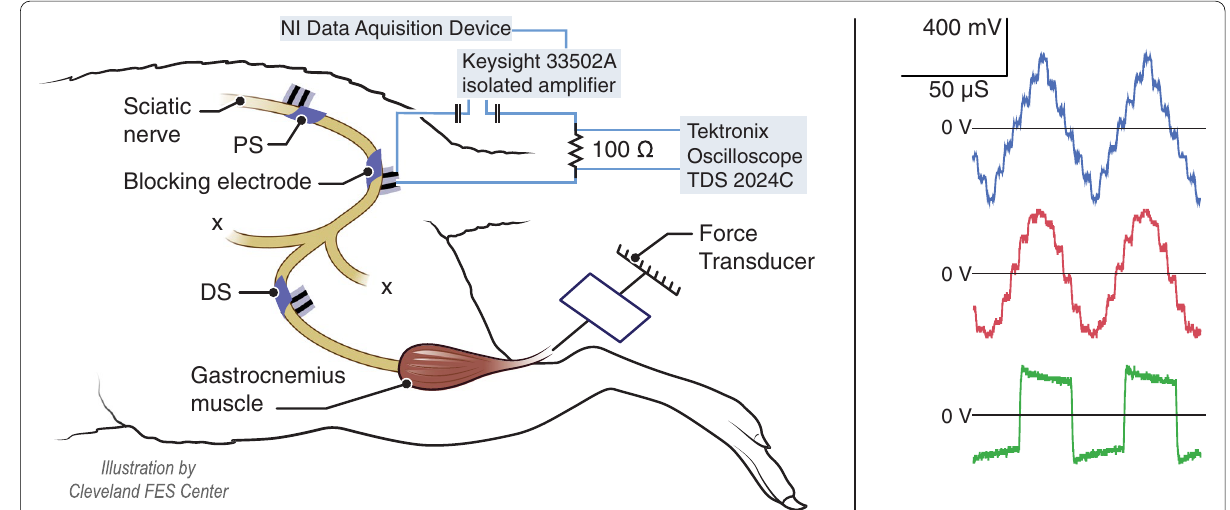
Fig. 2 Left: In-vivo experimental setup. A bipolar electrode was placed on the proximal portion of the sciatic nerve to elicit twitches from the gastrocnemius muscle. A second bipolar electrode was placed distally on the nerve. The block electrode was placed between the two stimulating electrodes on the sciatic nerve. The gastrocnemius tendon was attached to a force transducer to record muscle twitches. The blocking waveforms (12 samples per cycle) were delivered from a data acquisition device via an isolated amplifier. The voltage across a 100 Ω series resistor was recorded using an oscilloscope in order to measure peak current at BT. Right: The voltage across a series resistor (100 Ω) in the return path was measured on a high-impedance oscilloscope. Examples are at BT for 20